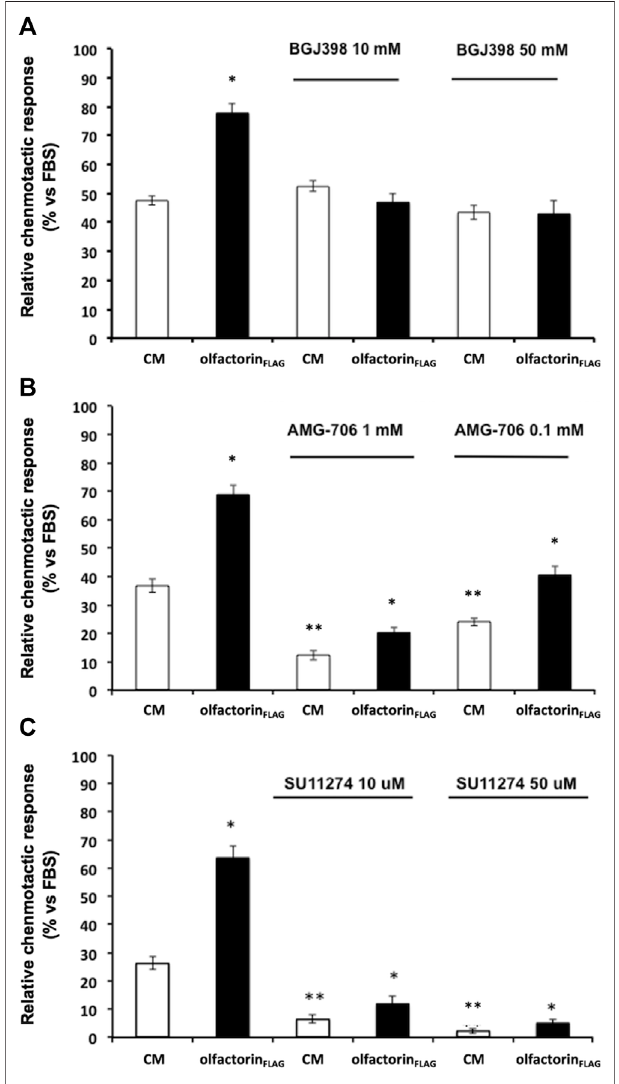
FIGURE 5 | Effect of growth factor receptor inhibitors on olfactorin FLAG - induced GN11 chemomigration. GN11 cells were pretreated with FGFR1-3 inhibitor BGJ398 (10 and 50 µM) (A) , VEGFR inhibitor AMG-706 (1 and 0.1 µM) (B) , HGFR inhibitor SU11274 (10 and 50 µM) (C) and exposed to the control CM or olfactorin FLAG . The results (mean ± SD; n. 4) are expressed as the relative chemotactic response of GN11 cells with respect to the stimulus exerted by 0.1%FBS. * p < 0.05 vs. respective CM; ** p < 0.05vs. response to the CM of cells not pretreated with blockers.